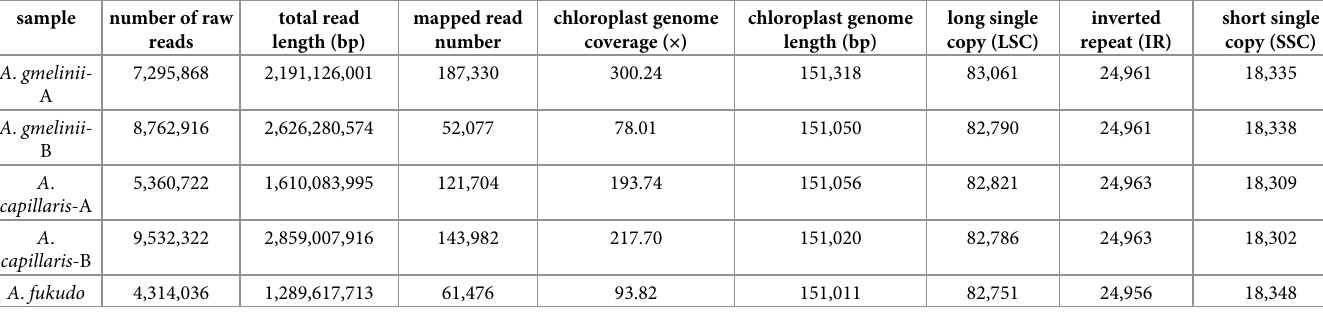
Table 1. Summary of the NGS data and chloroplast genomes of A . gmelinii , A . capillaris , and A . fukudo . sample